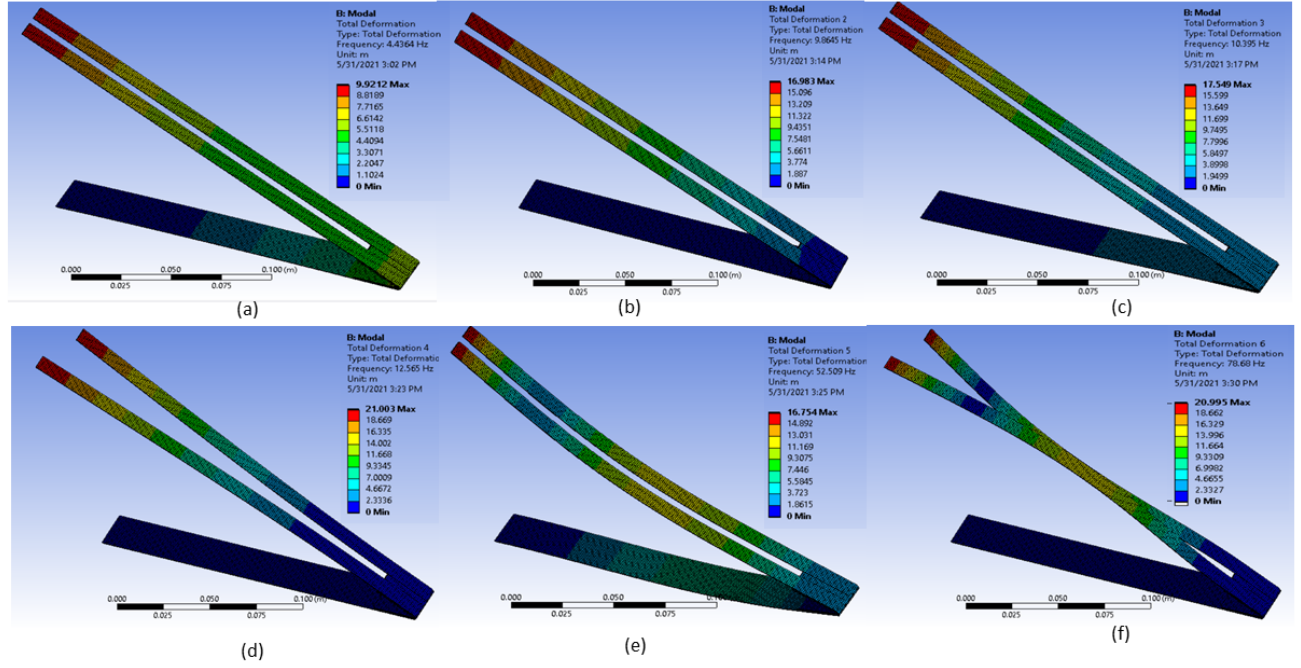
Figure 3. Deformed shapes of the first six resonances of BBBH obtained from modal analysis. ( a ) NF1, ( b ) NF2, ( c ) NF3, ( d ) NF4, ( e ) NF5, ( f ) and NF6.